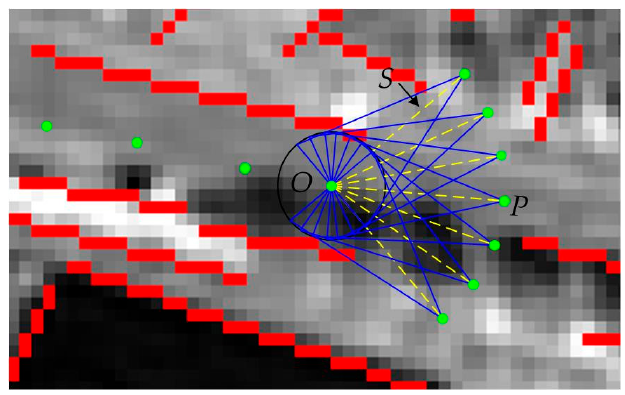
Figure 7. Sector Figure 7. Sector descriptor.